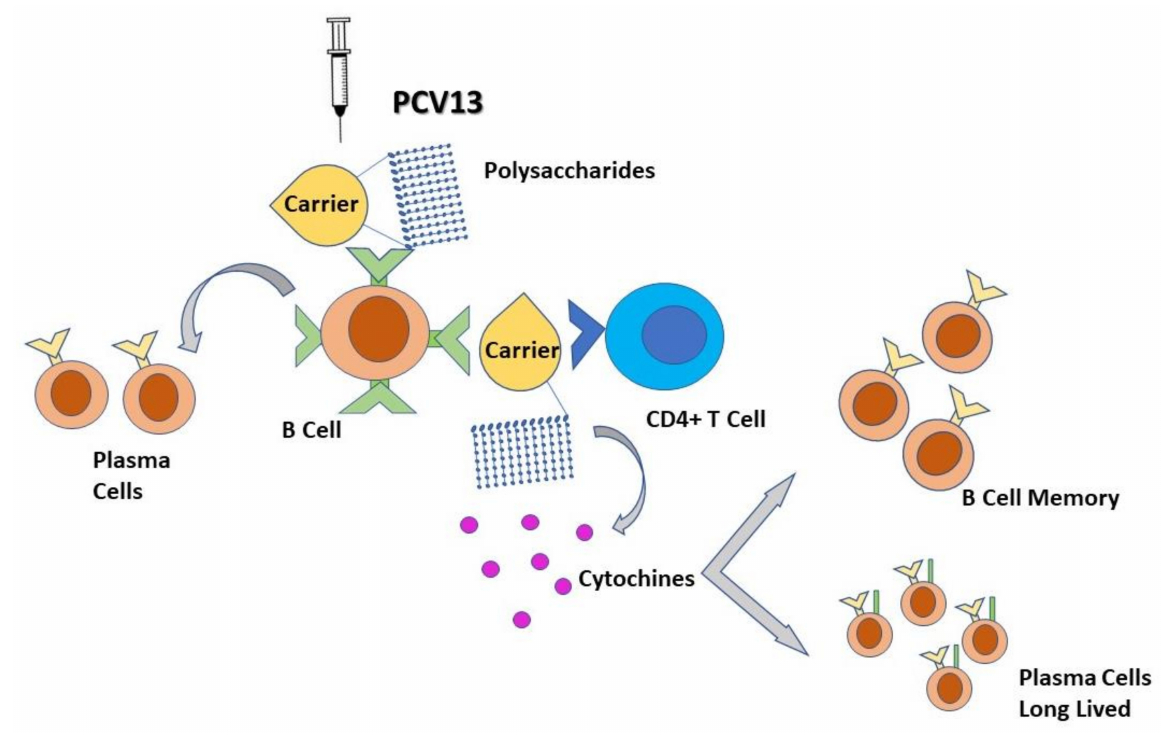
Figure 2. Schematic representation of the T-dependent mechanism of the PCV 13 vaccine. The polysaccharidic portion of PCV stimulates the production of plasma cells, while the carrier portion of PCV activates CD4+ T lymphocytes that induces memory B cell proliferation and long-lived plasma